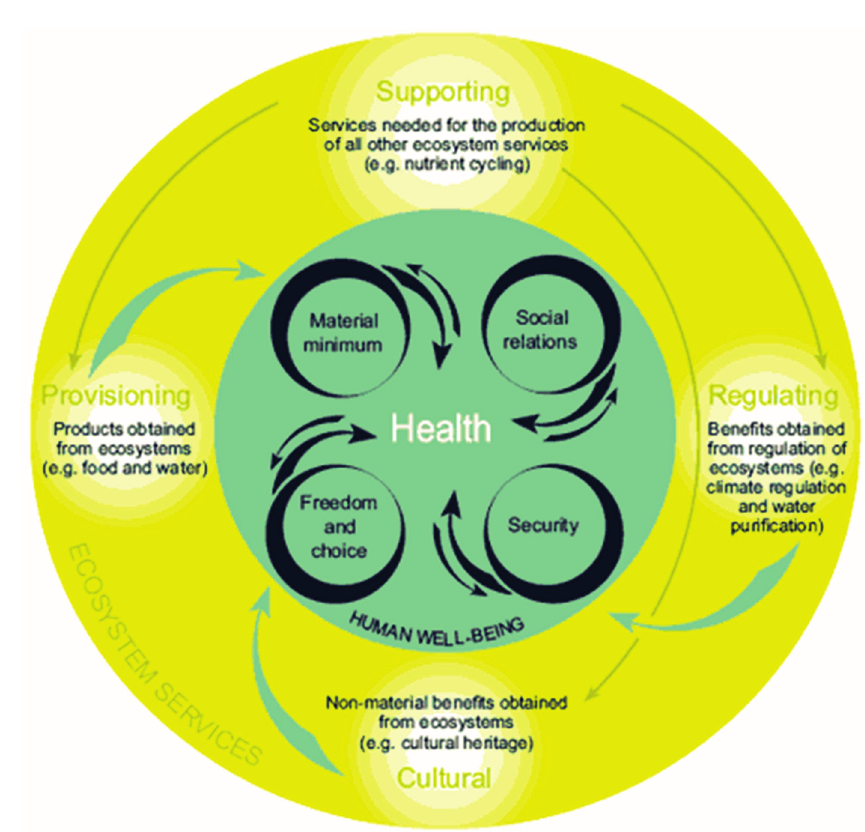
Figure 3. Ecosystem services and